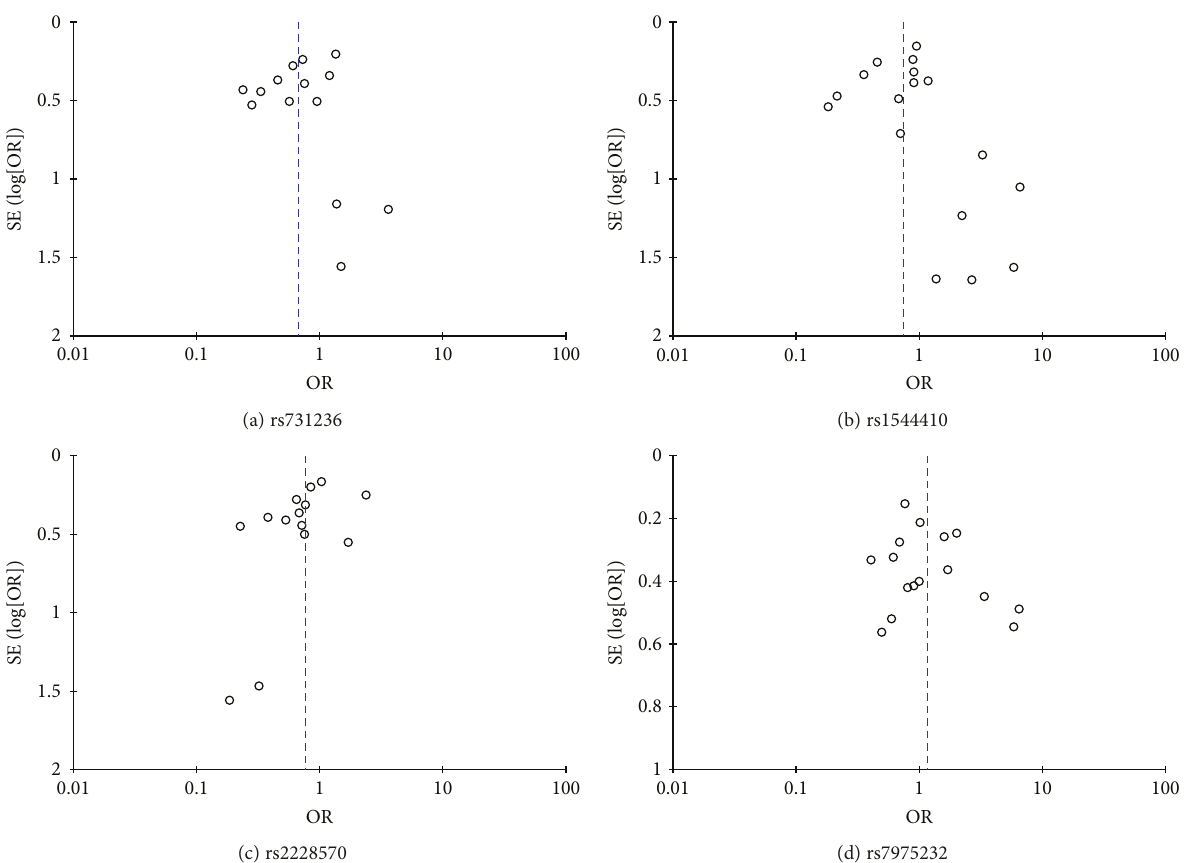
Figure 3: Funnel plot of the association of VDR polymorphisms with AITD risk in homozygote comparison model. Table 6: Egger ’ s test results for the publication bias of VDR polymorphisms and AITD risk. Comparison